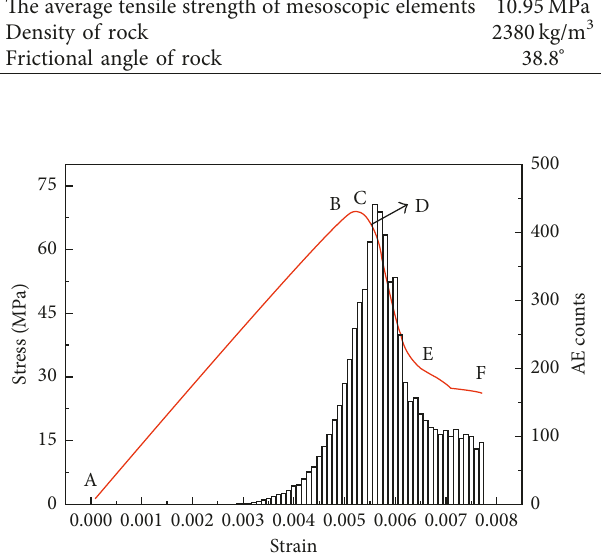
Figure 3: The stress-strain curve and acoustic emission of the uniaxial compressive test.